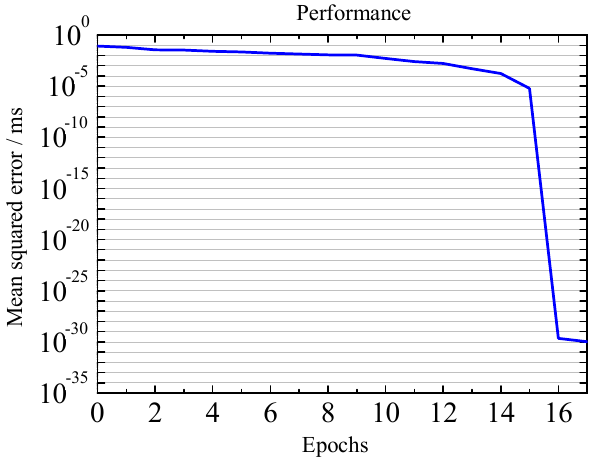
Figure 3. Training results of the ANN.